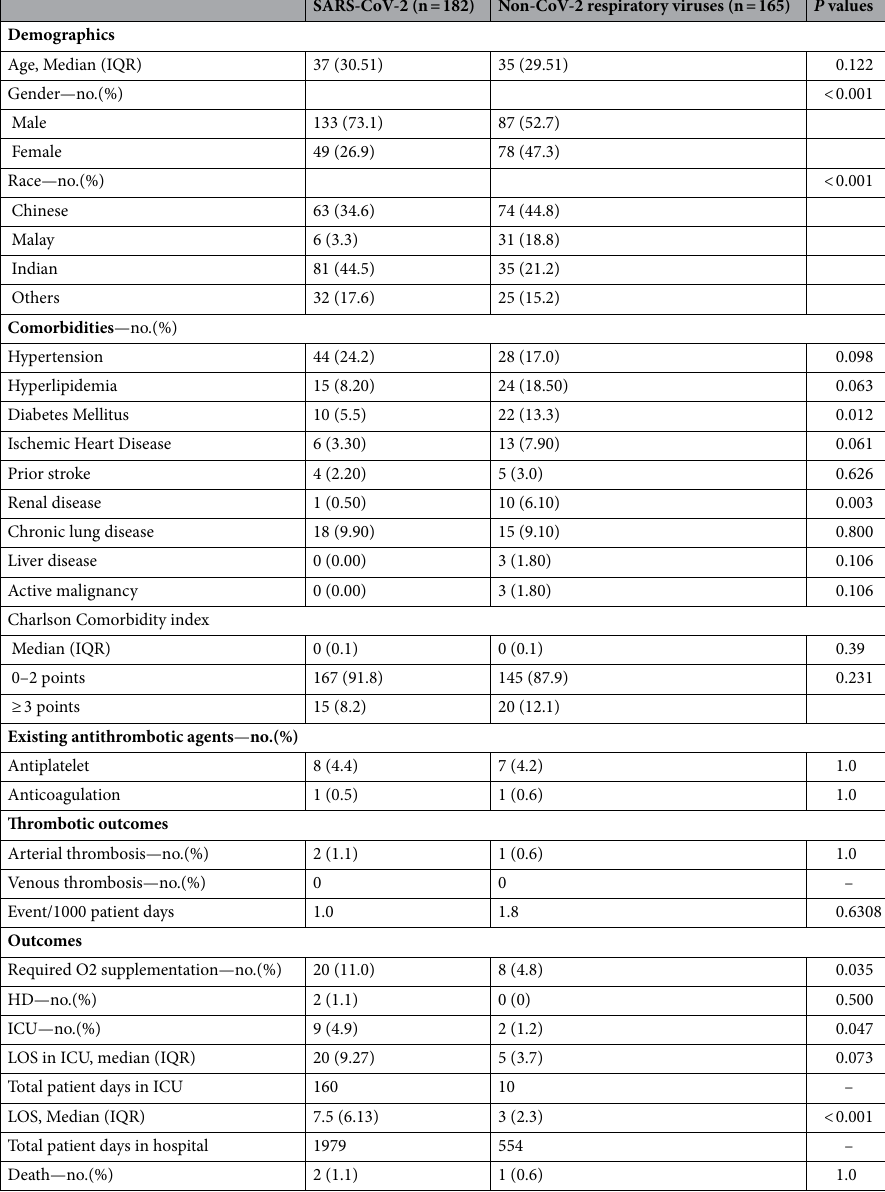
Table 1. Clinical characteristics, thrombotic events and outcomes of patients with SARS-CoV-2 and non- CoV-2 respiratory